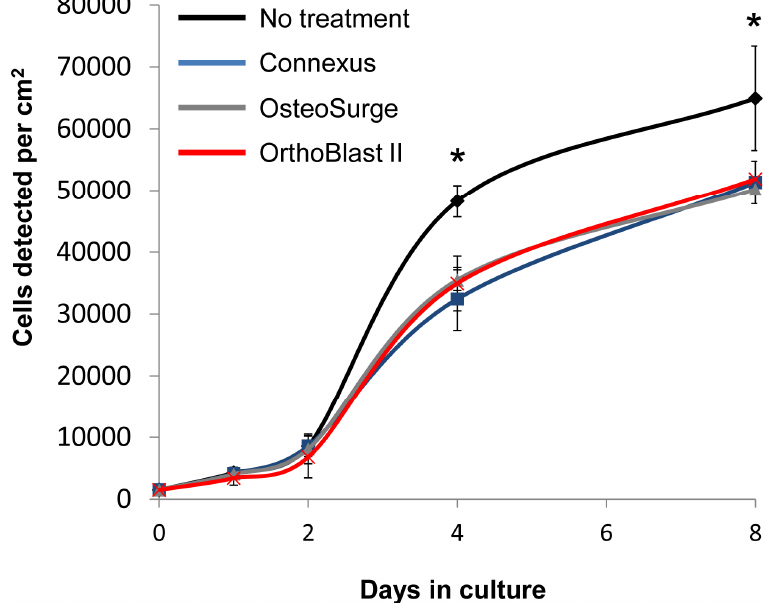
Figure 4. Cell growth curves for BMSC cultured in standard medium or 1:10 diluted extracts of DBM or DBM-poloxamer putties through 8 days ( n = 4 per substrate). Asterisk denotes significant difference ( * p < 0.05) against the no treatment control by ANOVA and Dunnett post